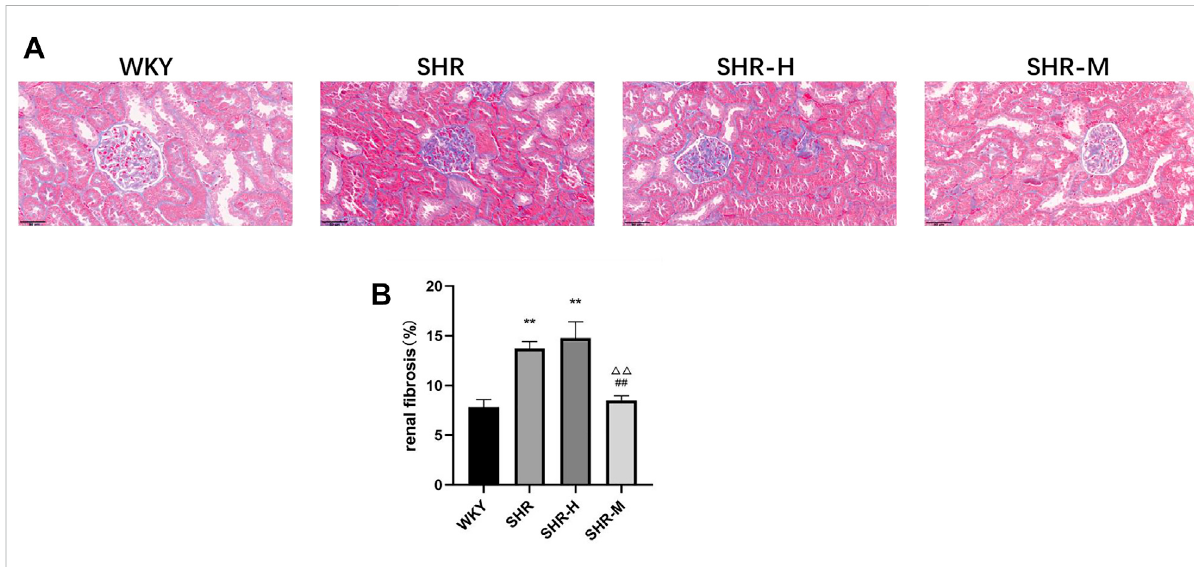
Effects of different intensity exercise training on renal tissue architecture and fi brosis. (A) Paraf fi n-embedded kidney sections (4 µm thickness) werestainedwithMasson ’ strichromestain(scalebar=20 µm). (B) Fibrosisareawascalculatedandshownbyacolumngraph.Allimagesweretaken at ×400 magni fi cation. Values are mean ± S. D ( n = 3in each group). * p < 0.05 and ** p < 0.01 versus the WKY group. △ p < 0.05 and △△ p < 0.01 versus the SHR group. # p < 0.05 and ## p < 0.01 versus the SHR-H